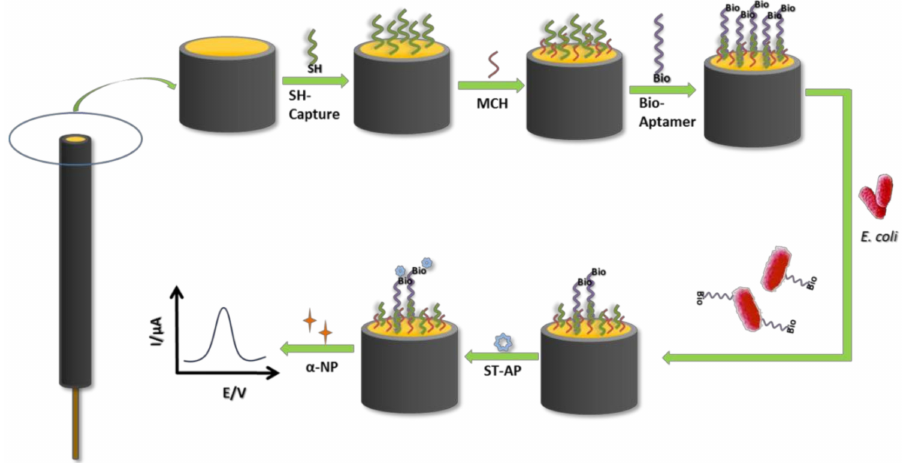
Figure 1. Schematic of the Electrochemical Biosensor for E. coli